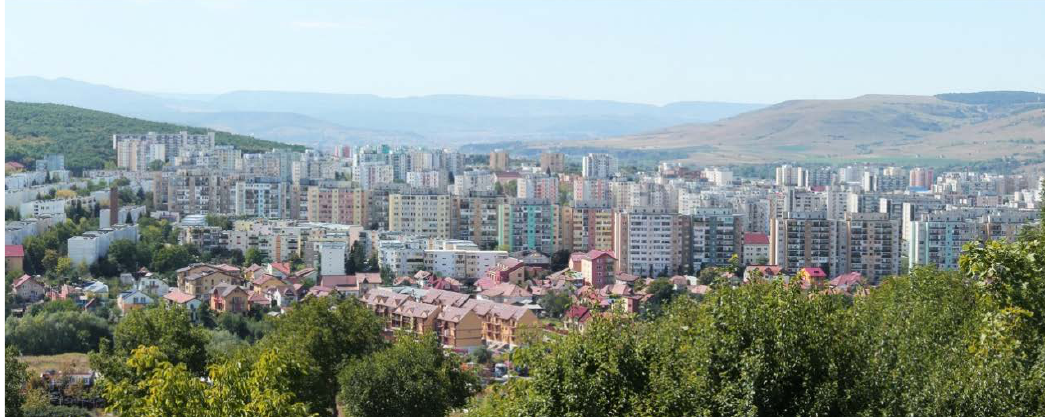
Figure 3: Communist housing blocks (background) versus Post-communist (foreground) residential units in Mănăştur, view from east to